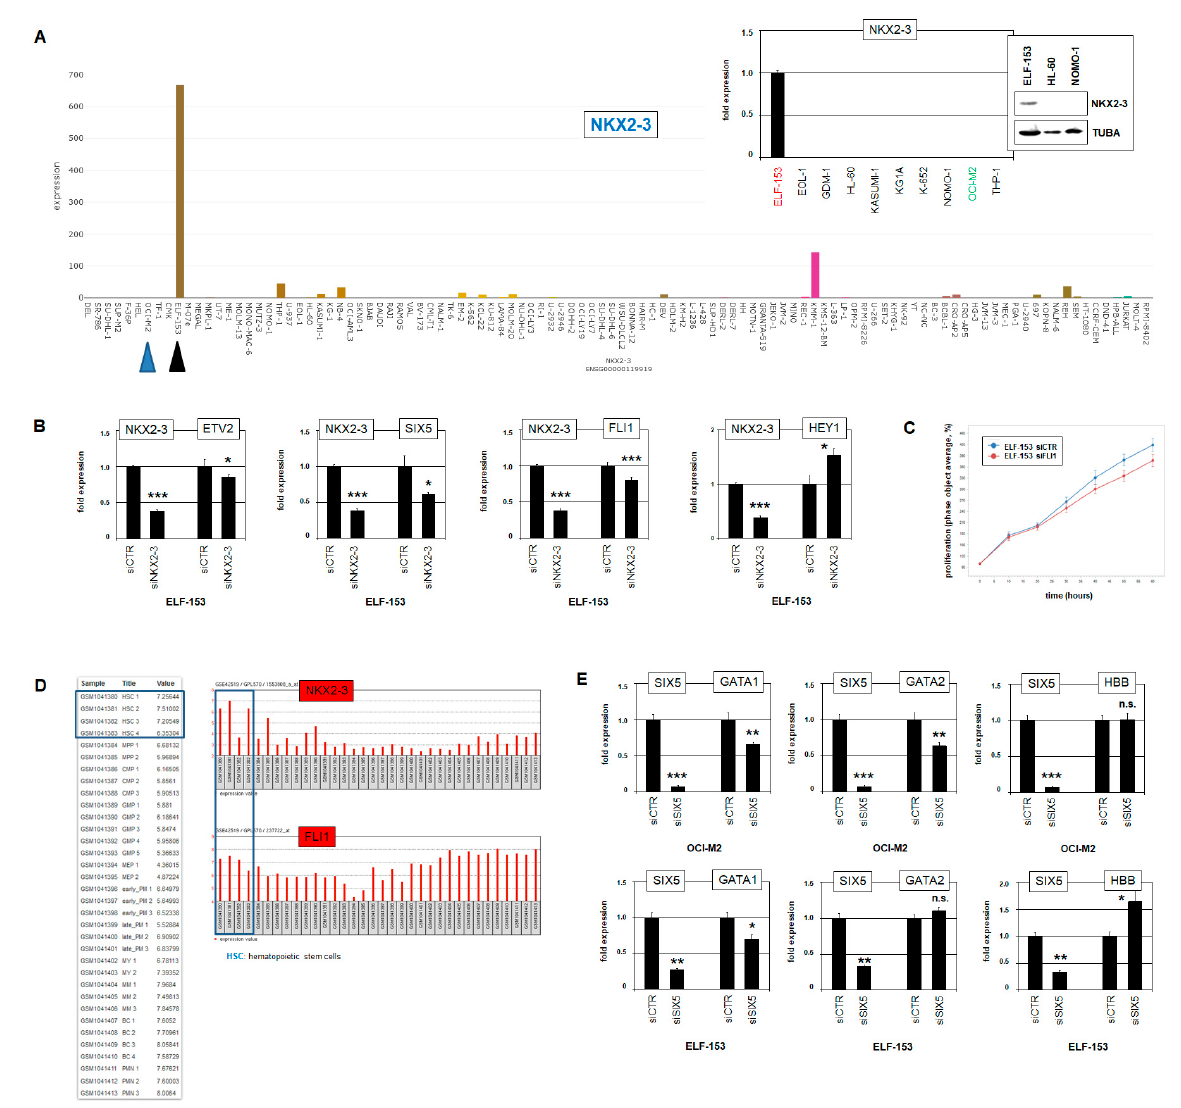
Figure 6. Expression and target gene analysis of NKX2-3. ( A ) LL-100 RNA-seq data show enhanced expression of NKL homeobox gene NKX2-3 in AML cell line ELF-153 (black arrowhead), while this gene is silent in OCI-M2 (blue arrow heads). Gene expression values are given as DESeq2 normalized count data. RQ-PCR and Western blot analyses of se-